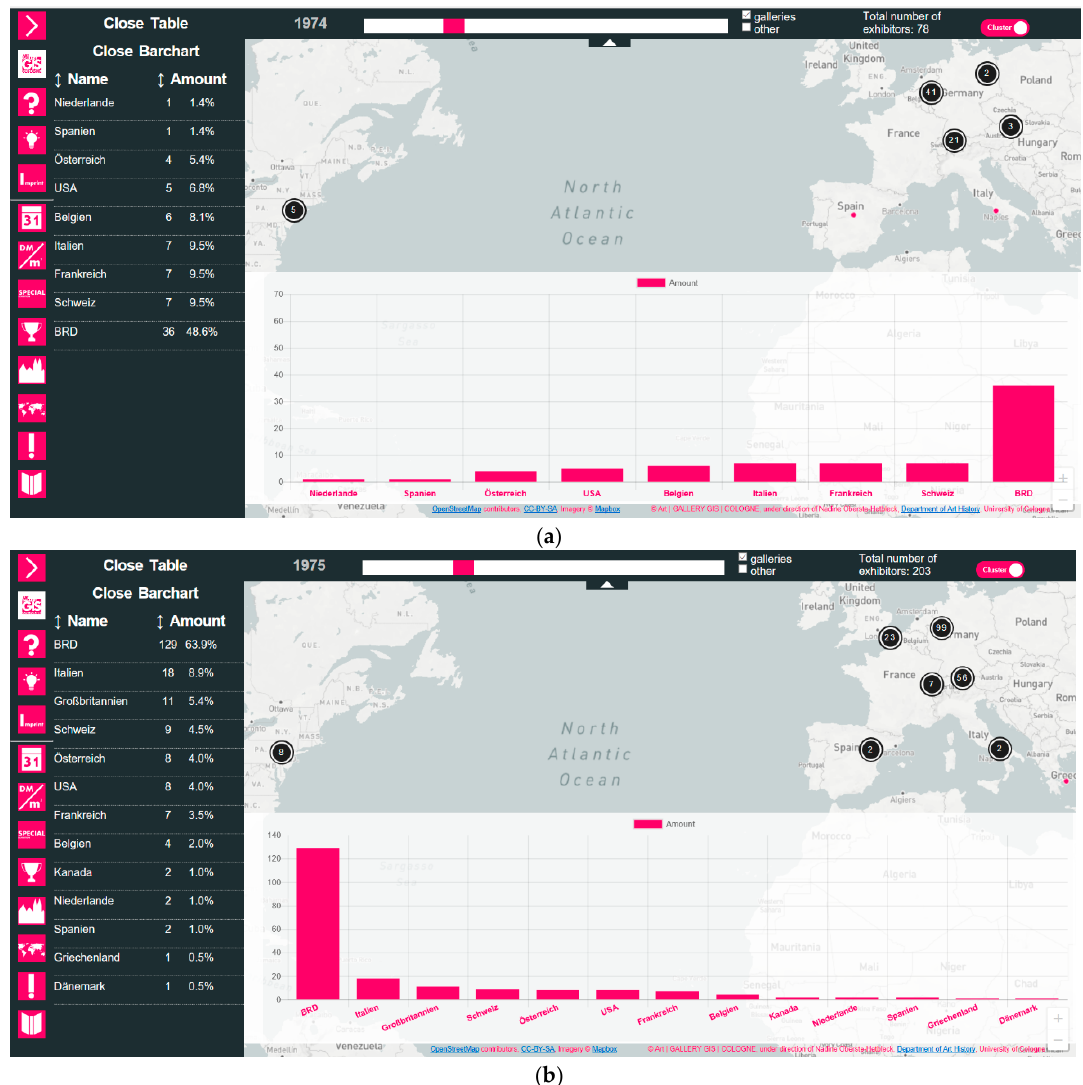
Figure 5. ART|GALLERY GIS|COLOGNE, number of galleries, art dealerships, and publishers of limited Figure 5. ART | GALLERY GIS | COLOGNE, number of galleries, art dealerships, and publishers of limited editions who participated in Kunstmarkt Köln->ART COLOGNE , three ways of visualization: tabular list, editions who participated in Kunstmarkt Köln- > ART COLOGNE , three ways of visualization: tabular bar chart, and map ( a ) 1974, ( b ) 1975. Used by permission. © ART|GALLERY GIS|COLOGNE. list, bar chart, and map ( a ) 1974, ( b ) 1975. Used by permission. © ART | GALLERY GIS |